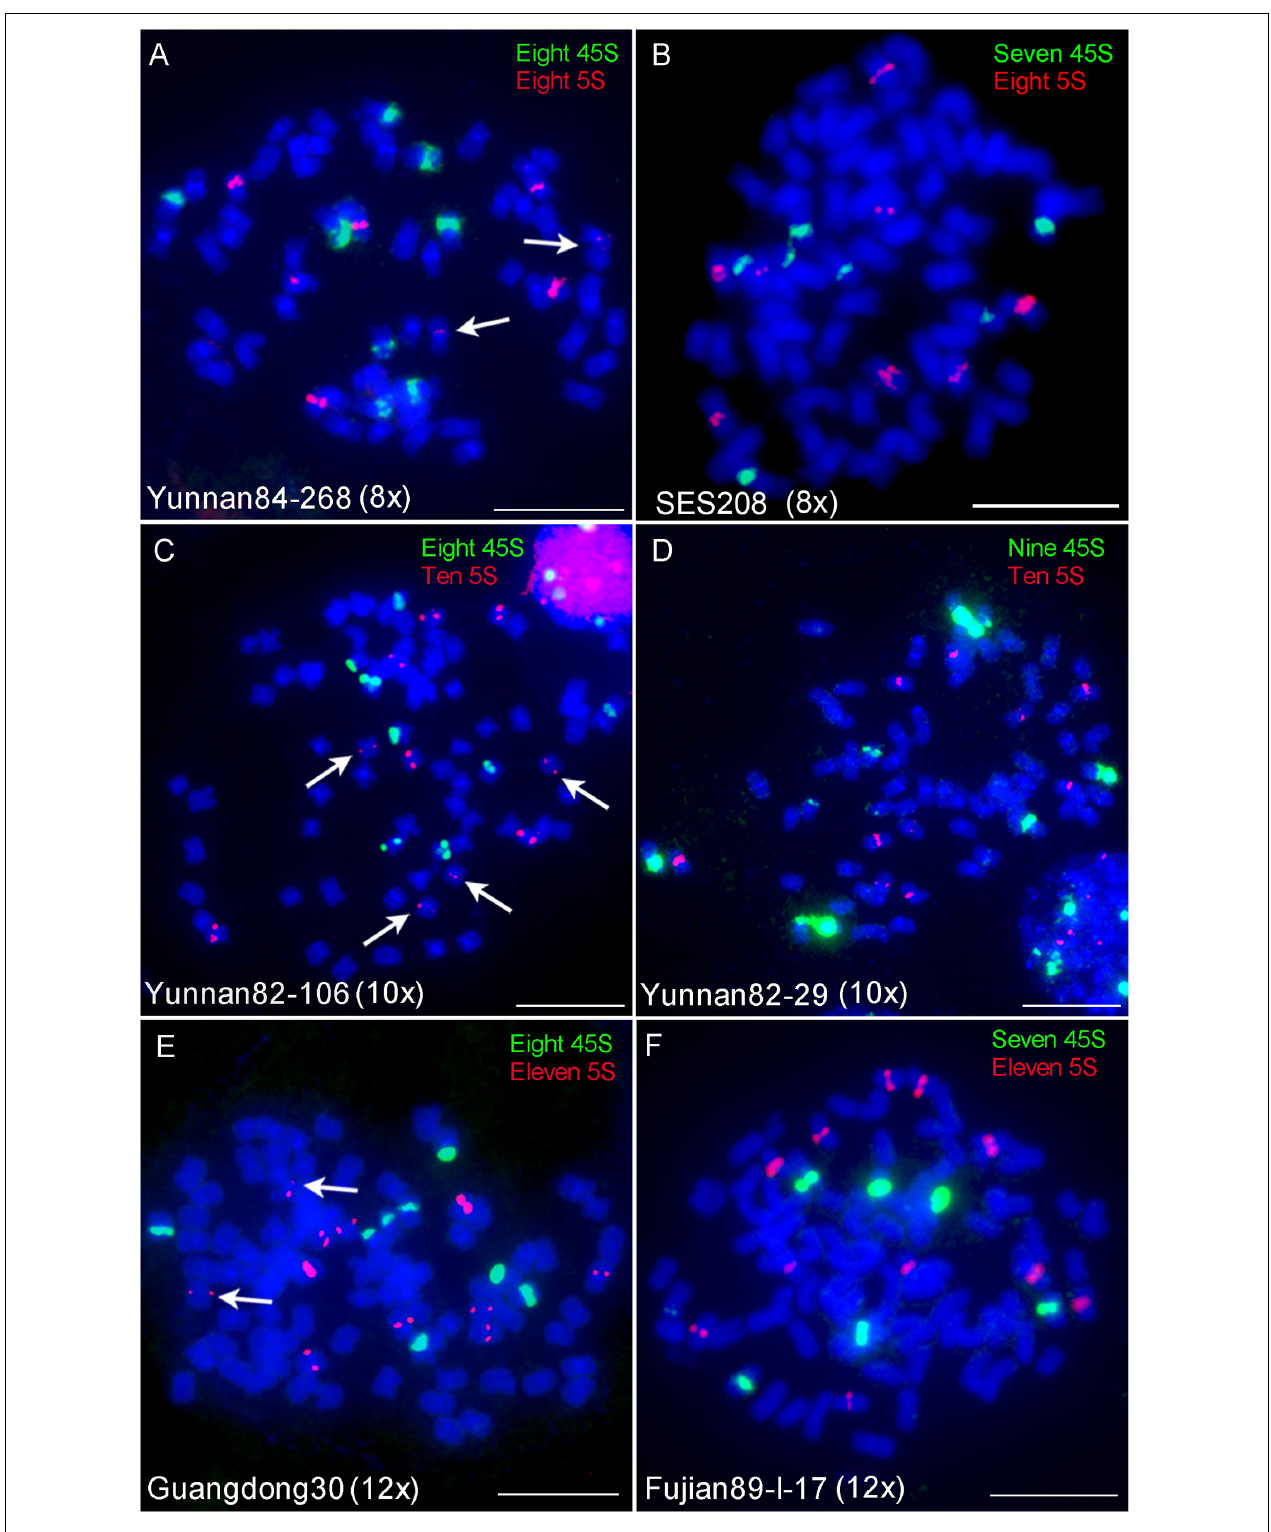
FIGURE 3 | FISH mapping of 45S and 5S rDNAs in S. spontaneum . Dual-color FISH assay using probe pairs of 45S (green) and 5S rDNA (red) in six S. spontaneum clones Yunnan84-268 (octaploid) (A) , SES208 (octaploid) (B) , Yunnan82-106 (decaploid) (C) , Yunnan82-29 (decaploid) (D) , Guangdong30 (dodecaploid) (E) , and Fujian89-I-17 (dodecaploid) (F) . The signal numbers of each probe are displayed. Arrows indicate the weak signals. Scale bars, 10 µ m.